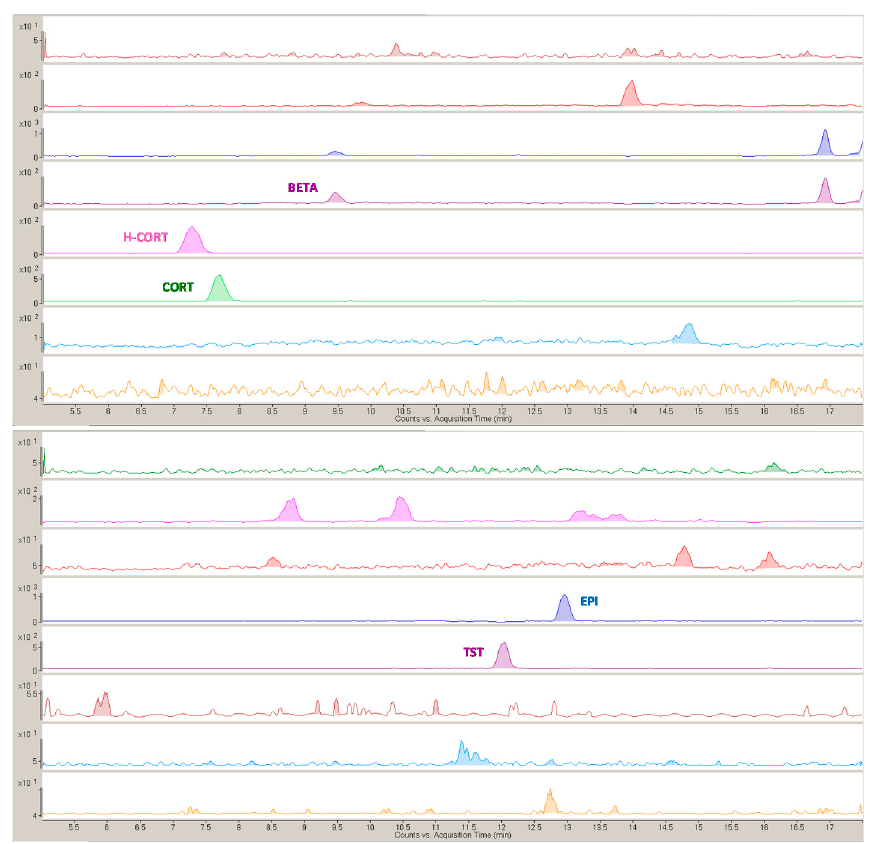
Figure 3. Representative multiple-reaction monitoring (MRM) chromatograms of the MSPE eluate from human plasma sample.